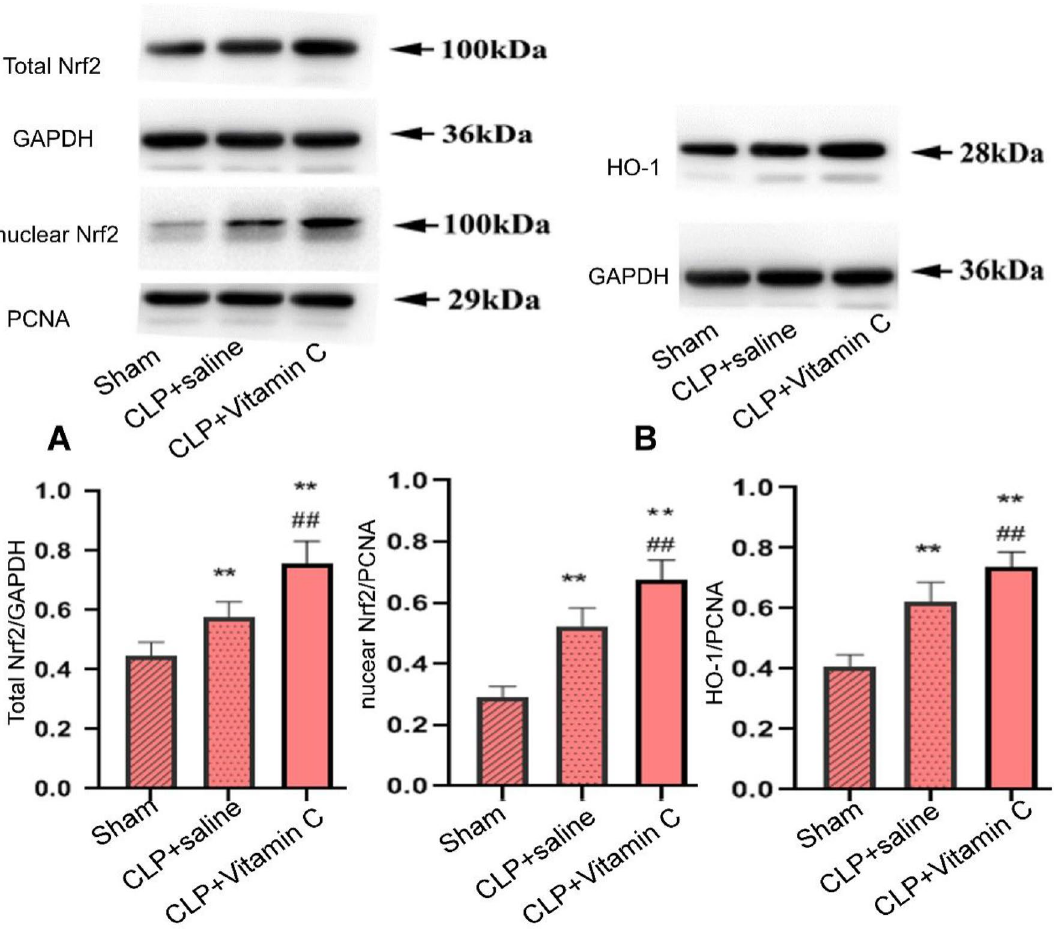
Figure 5. Comparison of the protein expression levels of the total and nucleus Nrf2 and cytoplasmic HO-1 in three groups of CLP-induced septic rats. ( A ) The expression of total and nuclear Nrf2 in hippocampus. ( B ) The expression of cytoplasmic HO-1 in hippocampus. Compared with the sham group, the nuclear and total Nrf2 and HO-1were significantly (P = 0.004) increased in both the CLP + saline group and the CLP + vitamin C group 24 h after CLP modeling surgery. Compared with the CLP + saline group, the expression levels of the nuclear and total Nrf2, and HO-1 were significantly (P = 0.001) increased in the CLP + Vitamin C group. Values are expressed as mean ± standard deviation (n = 5). * P < 0.05 and ** P < 0.01 compared with the sham group; ## P < 0.01 compared with CLP + saline group. CLP cecal ligation and puncture, Nrf2 nuclear factor erythroid 2-related factor 2, HO-1 heme